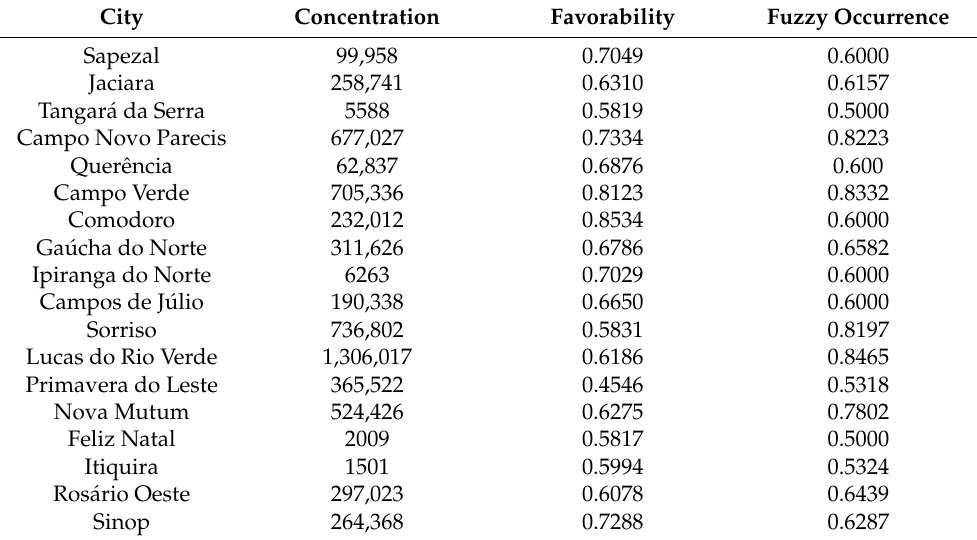
Table 5. Possibility of occurring ASR according to